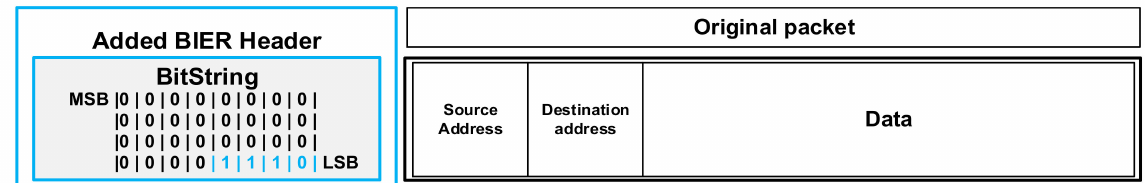
Figure 6. BIER header with a Bit-String. MSB—Most Significant Bit. LSB—Least Significant